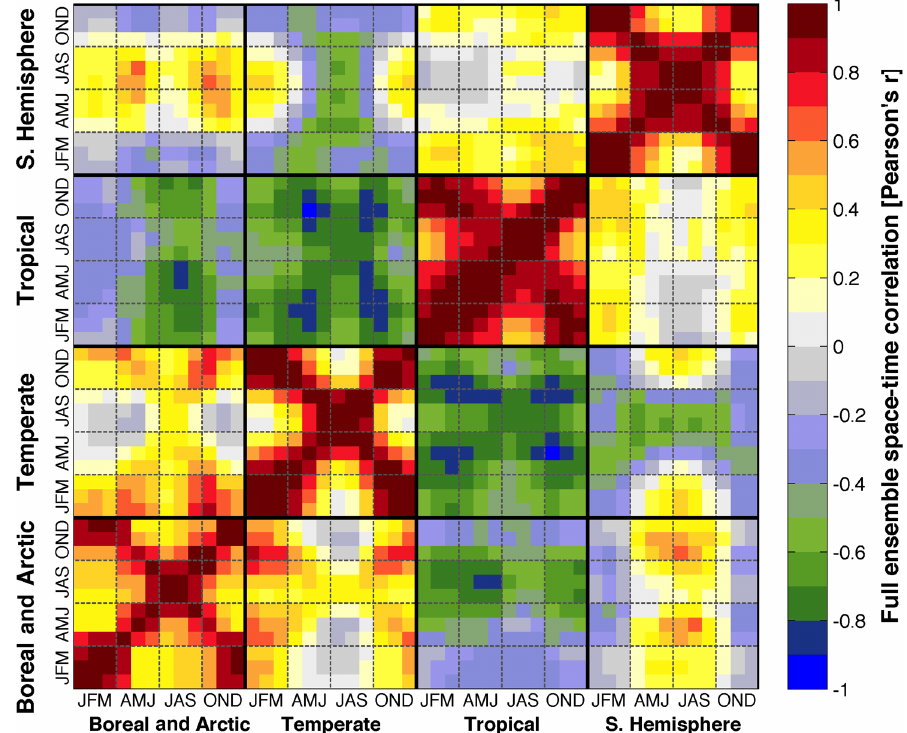
Figure 7. The full ensemble (FE) spatial and temporal error covariance, summarized as a monthly error correlation across boreal and Arctic ( > 55 ◦ N) temperate (23–55 ◦ N), tropical (23 ◦ S–23 ◦ N) and Southern Hemisphere ( < 23 ◦ S) latitudes. A correlation between two location- and-time indices indicates the degree to which models consistently over- or under-predict wetland CH 4 emissions relative to the ensemble mean. The non-zero off-diagonal correlation patterns emerge as a function of varying biogeochemical commonalities across ensemble mem- bers, such as wetland CH 4 dependencies on temperature, carbon availability and wetland extent. Negative correlations between tropical and Northern Hemisphere extratropical (i.e. temperate, boreal and Arctic) wetlands emerge as a function of a global constraint on wetland CH 4 emissions (166TgCH 4 yr − 1 ±